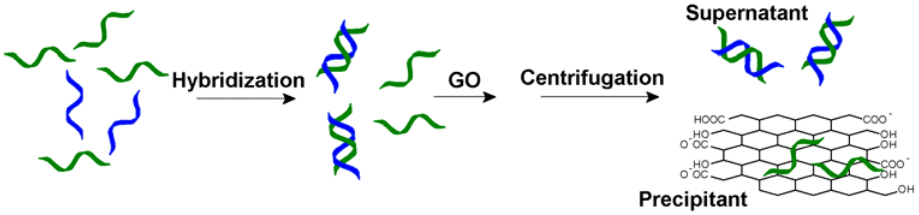
Figure 1. A strategy for graphene oxide (GO)-based selective removal of single-stranded (ss)-DNA. In a mixture of ss- and double stranded (ds)-DNA, GO adsorbs the former more quickly to achieve separation. After a simple centrifugation step, only ds-DNA is left in the supernatant